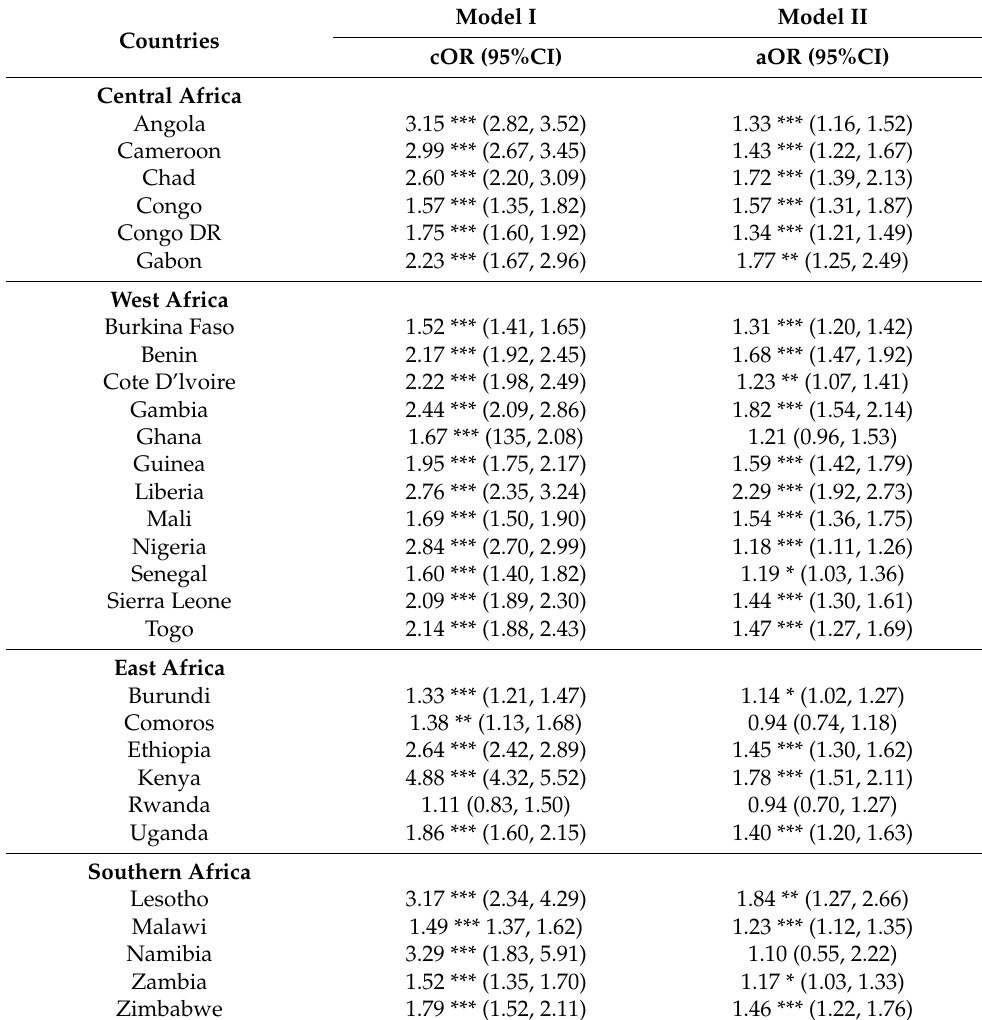
Table 5. Logistic regression on the association between mass media exposure and safer sex negotiation in sub-Saharan Africa disaggregated by